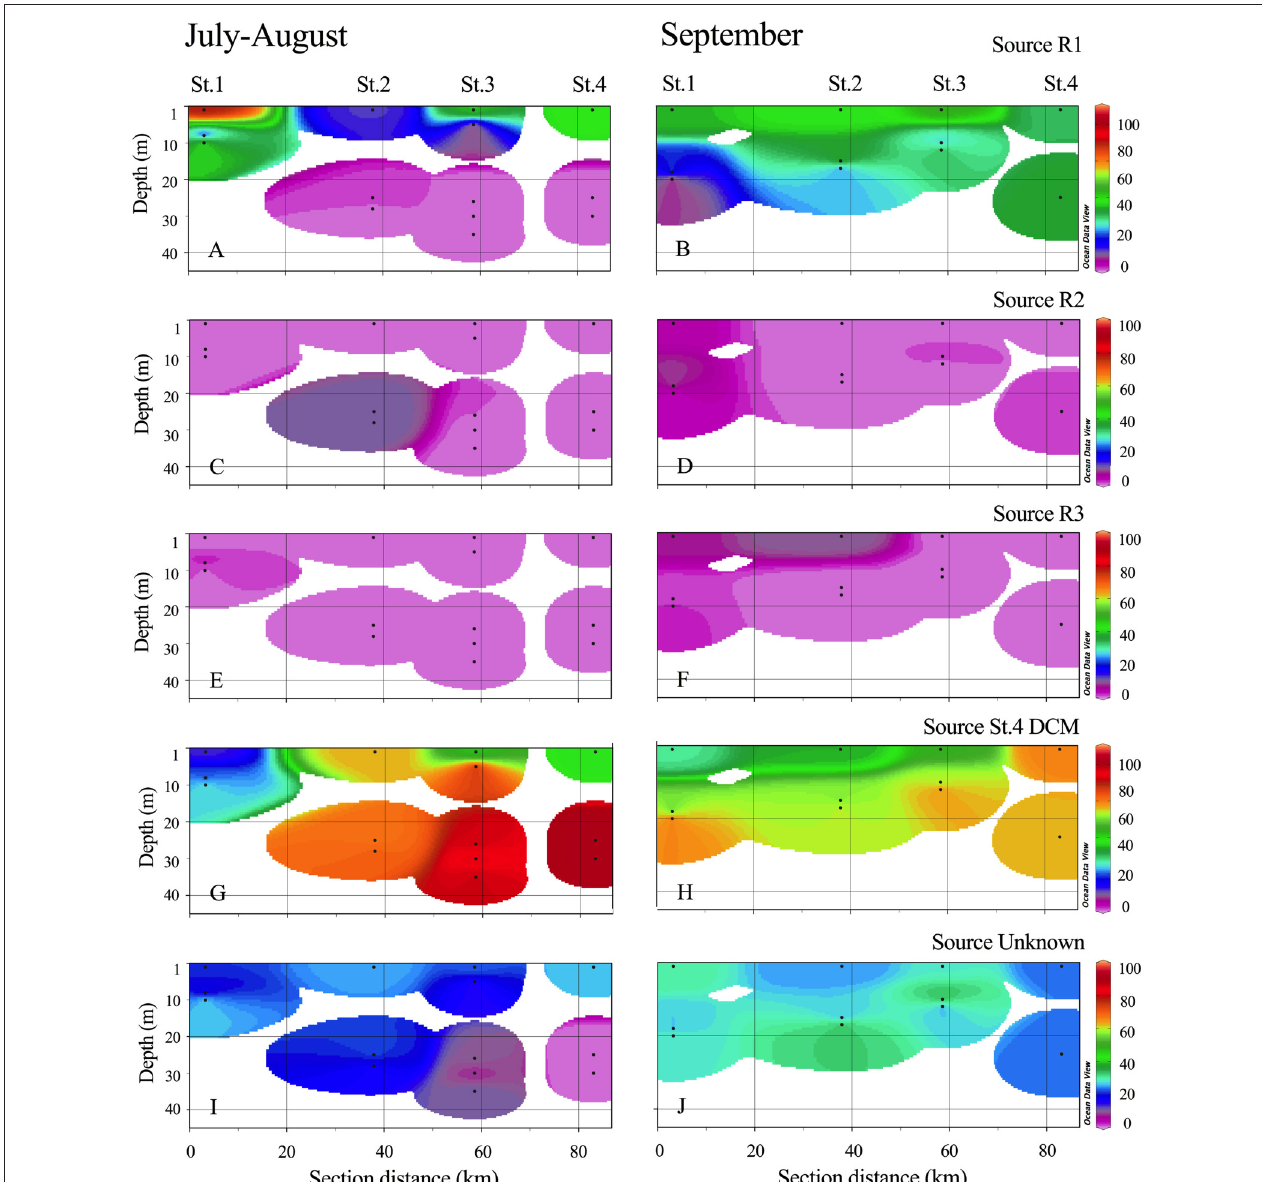
FIGURE 9 | The likely contribution (%) of each defined source bacterial populations from R1 (A–B) , R2 (C–D) , R3 (E–F) , St.4 DCM (G–H) and when a source could not be identified (I–J) in the fjord (upper 45 m) is plotted for the two periods using SourceTracker analysis. Transects are plotted using weighted-average extrapolation between points using Ocean Data View (Schlitzer,